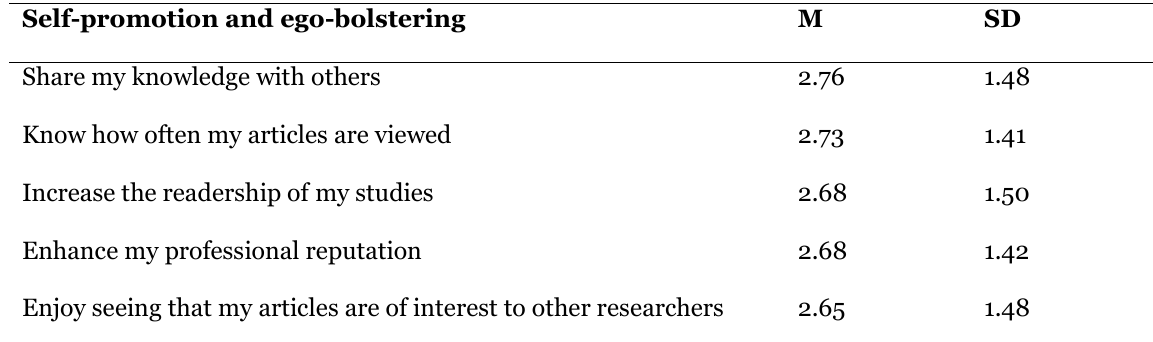
Self-Promotion and Ego-Bolstering Self-promotion and